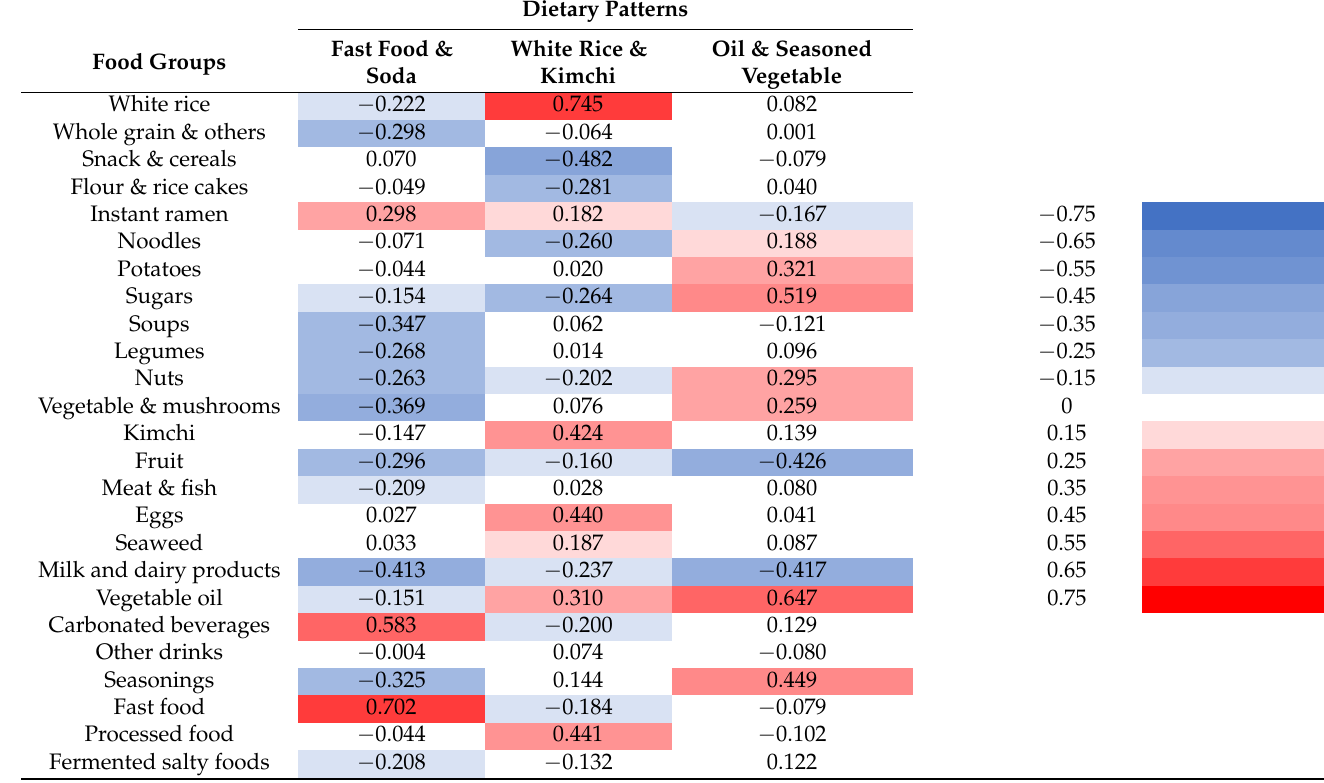
Table 2. Factor loading matrix for major dietary patterns in Korean children and adolescents. Dietary